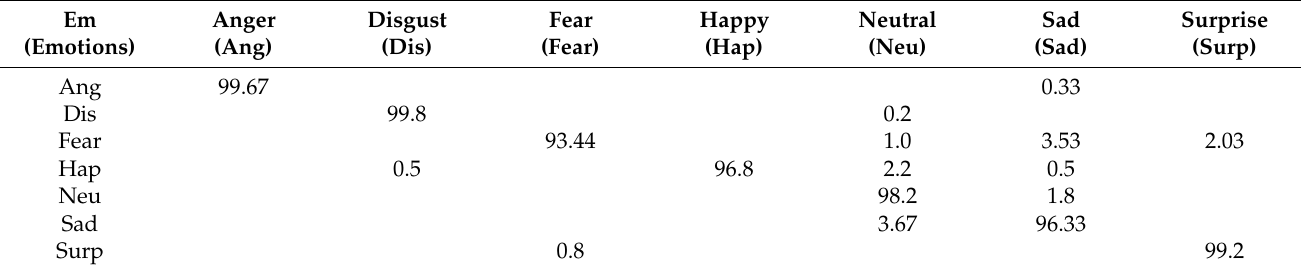
Table 2. Matrix representing the confusions in JAFFE dataset.